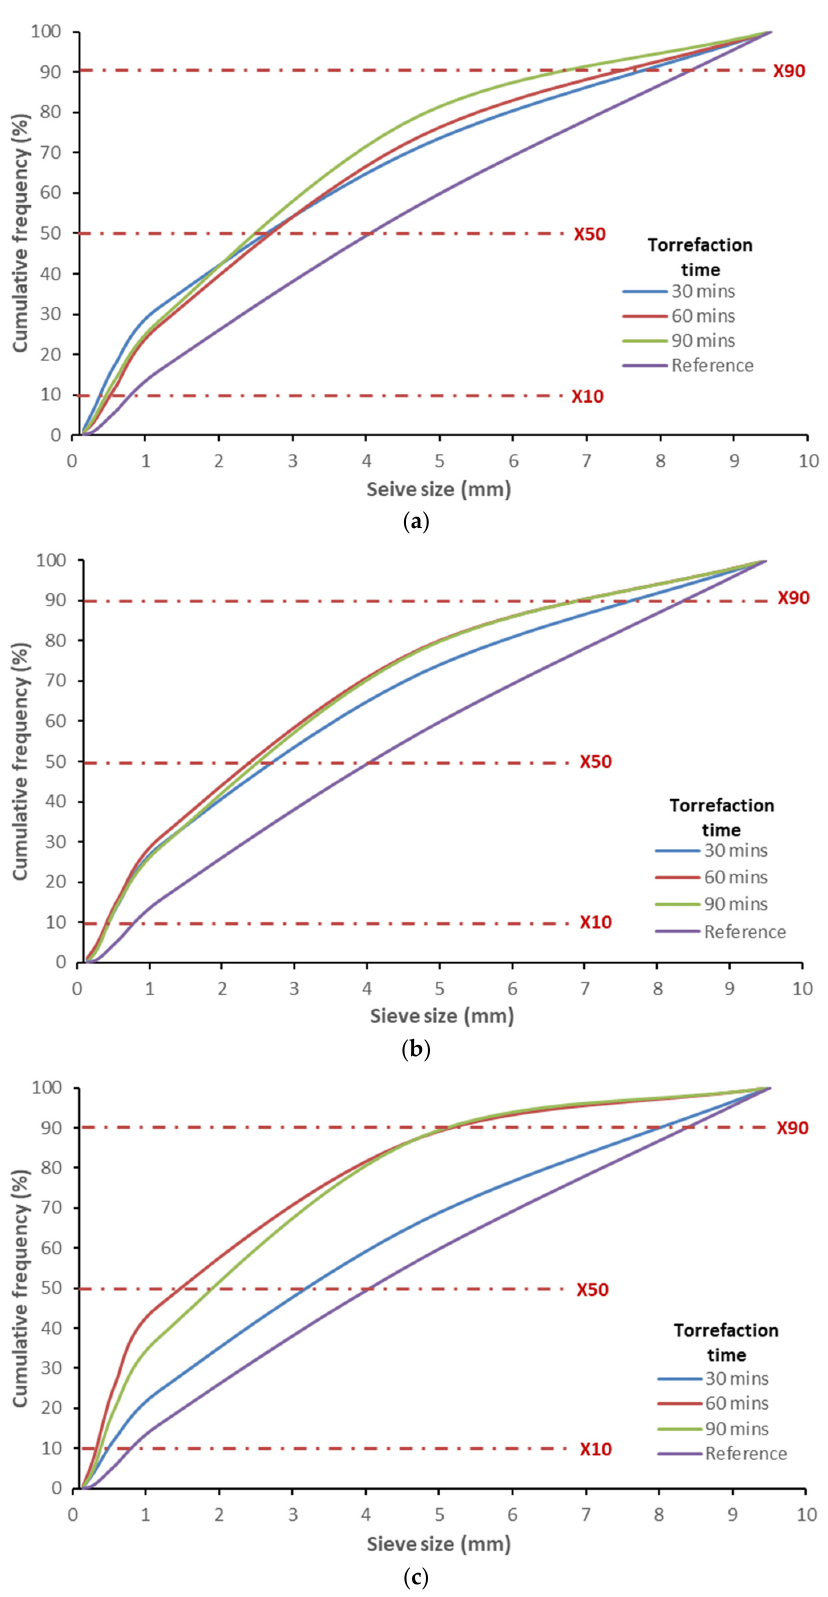
Figure 5. Particle size analysis of raw biomass compared with torrefied corncobs at: ( a ) 200 ◦